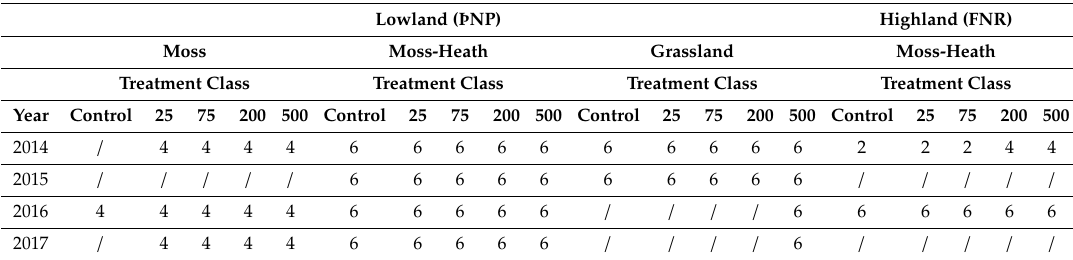
Table 1. The scheme for acquisition and number of subplot photographs in the experimental plots,